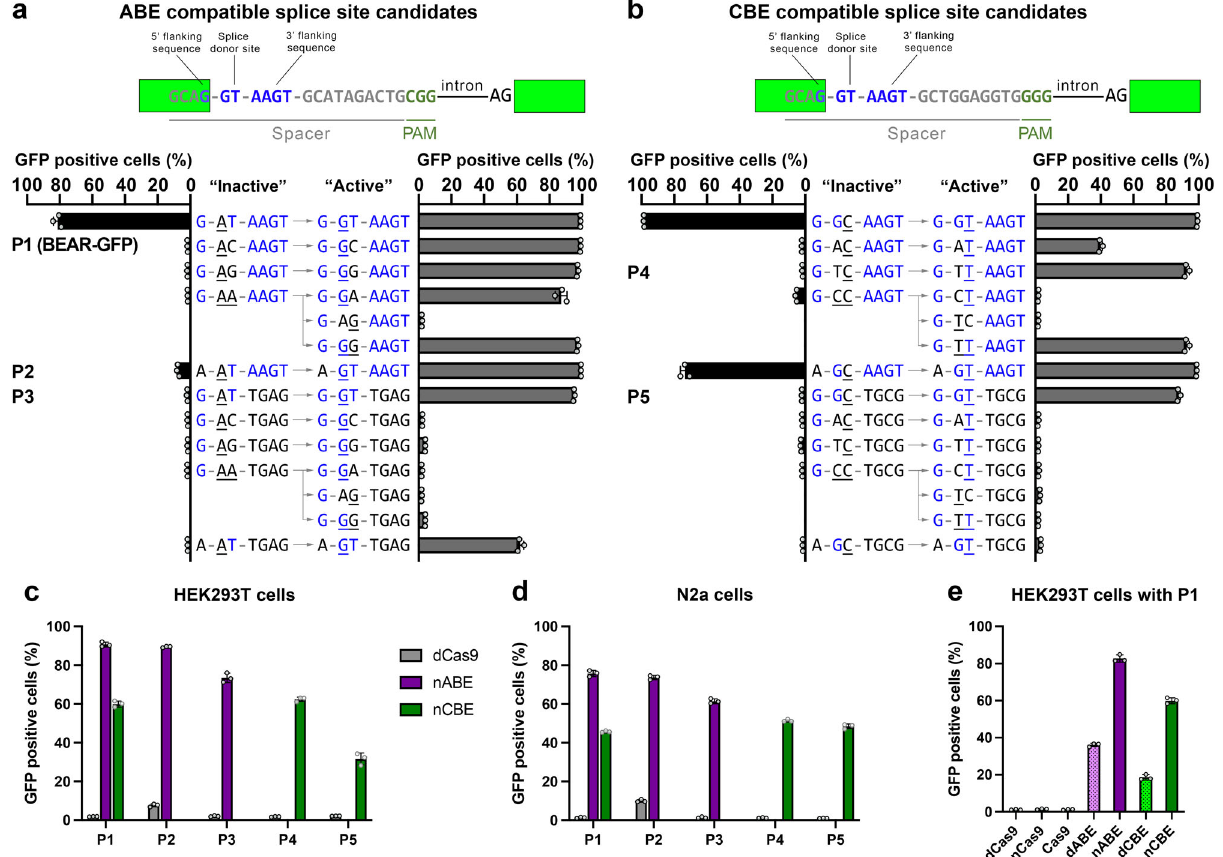
Fig. 2 Splice site variants for identifying candidate BEAR sequences. Flow cytometry measurements of GFP positive HEK293T cells, transfected with plasmids harbouring systematically altered splice sites (expected “ inactive ” sequences), which hold the possibility of being converted by ABE ( a ) or CBE ( b ) to sequences expected to be functional, “ active ” splice sites. BEAR plasmids with inactive and active splice sites were generated by molecular cloning, the latter representing the maximum fl uorescence that can be achieved by base editing. The sequences between the column charts represent the intended “ inactive ” or “ active ” splice donor site and fl anking sequence pairs. Letters highlighted in blue indicate the bases that correspond to the canonical 5 ’ - G GT AAGT - 3 ’ sequence (upper panels); the altered bases in the GT splice donor sites are underlined. Five sequence pairs (P1-P5) with minimal fl uorescence for the inactive and maximal fl uorescence for the active splice donor site were selected for further analyses as detailed in Fig. 2c-e. Note that the target sequence in the a and b panels are different. Flow cytometry measurements of GFP positive HEK293T ( c and e ) and N2a ( d ) cells co-transfected with a selected reporter plasmid harbouring an inactive splice site and base editor or control nuclease constructs as indicated in the fi gure. Columns represent means, + /- SD of three parallel transfections (grey circles).